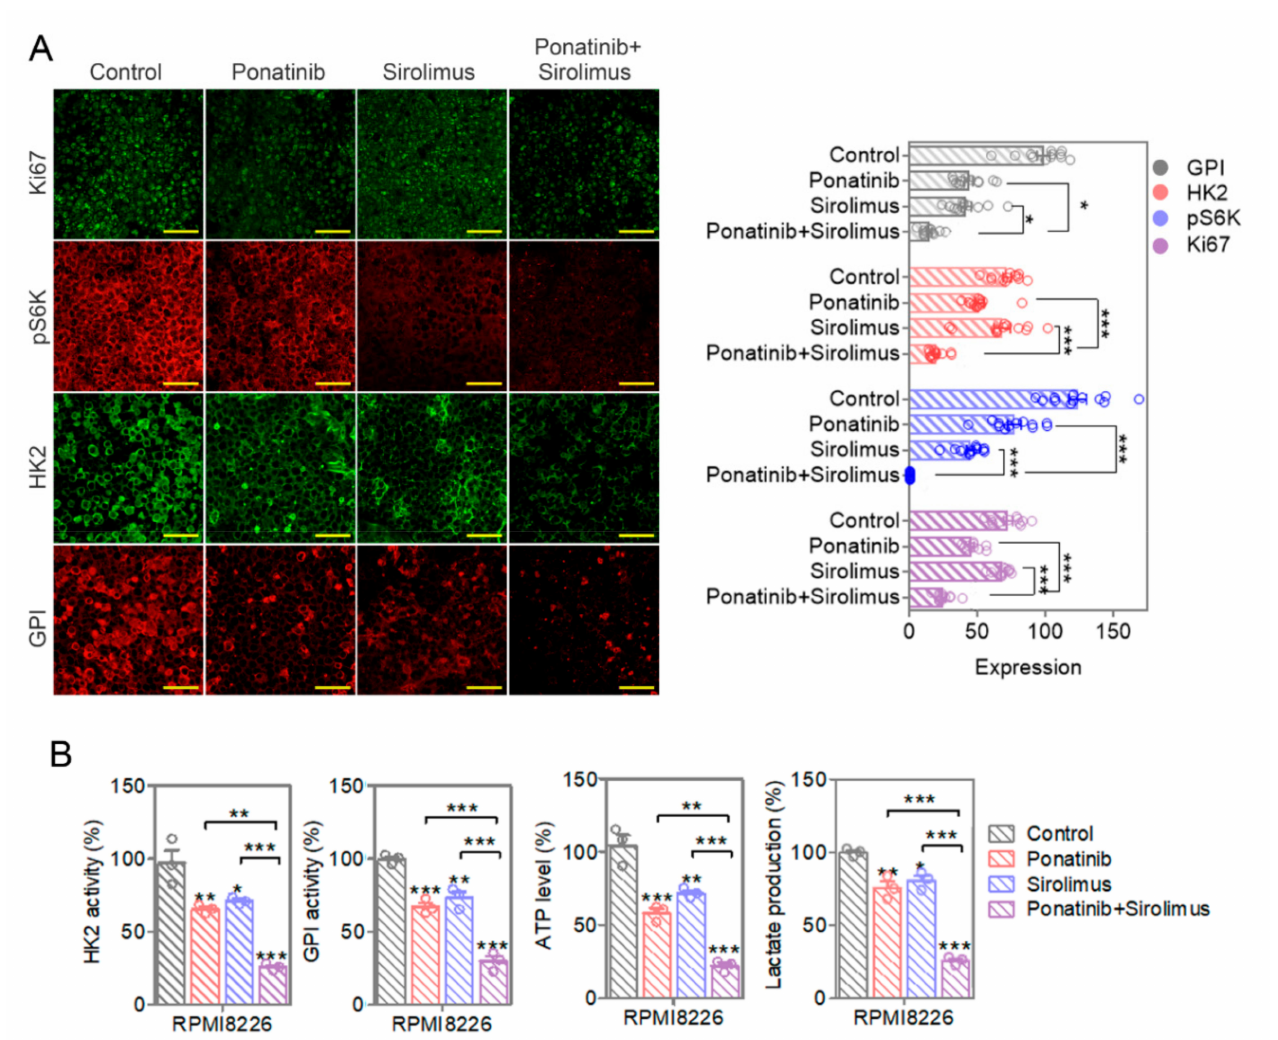
Figure 7. Ponatinib-and-sirolimus combination reduces the levels of Ki67 proliferation marker, mTORC1 activity, and glycolysis rate-limiting enzymes in multiple myeloma tumors. ( A ) Fixed tumor tissue samples were stained with antibodies specific to Ki67 (for proliferation), pS6K (for mTORC1 activity), HK2, and GPI protein levels (for glycolysis). The fluorescent images were quantified by using ImageJ software and plotted as a histogram. Scale bar is 50 µ m. ( B ) Tumor tissue lysates were prepared, and HK2 and GPI activity, ATP, and lactate levels were quantified. The data are representative of 3 samples from each group. Data are presented as mean ± SEM; t -test: * p < 0.05, ** p < 0.01, and *** p <